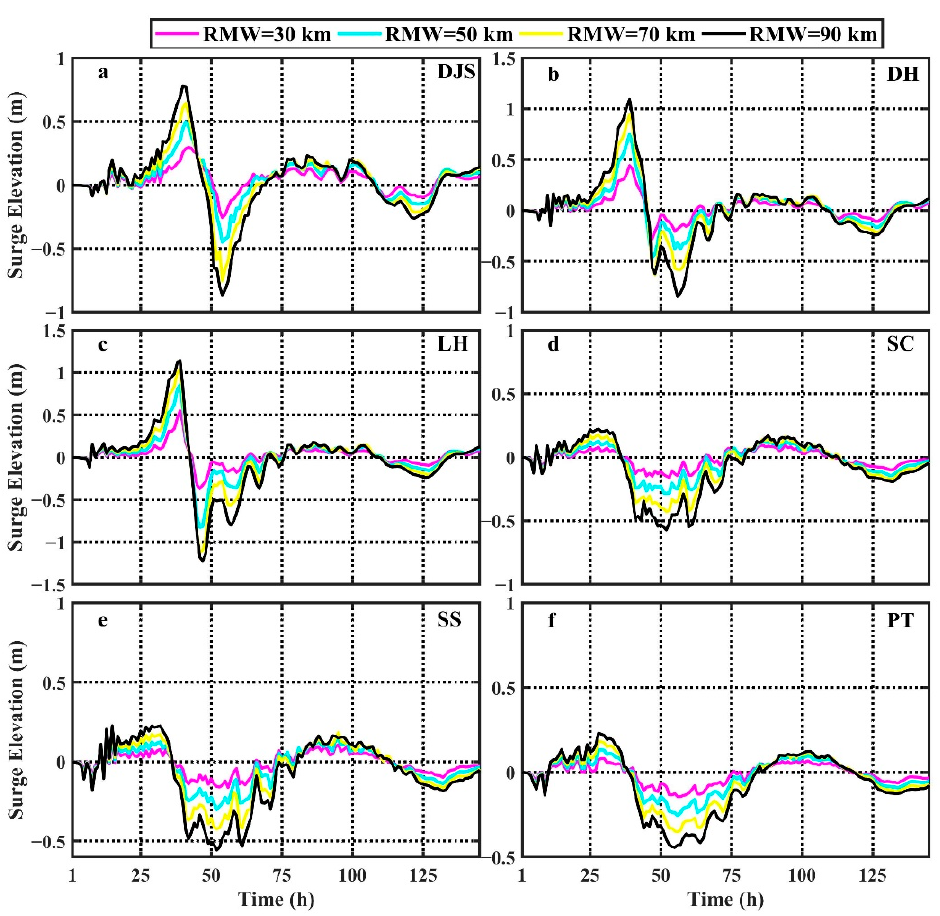
Figure 7. Time series of surge elevation in different RMW experiments at: ( a ) DJS, ( b ) DH, ( c ) LH, ( d ) SC, ( e ) SS, and ( f ) PT station.